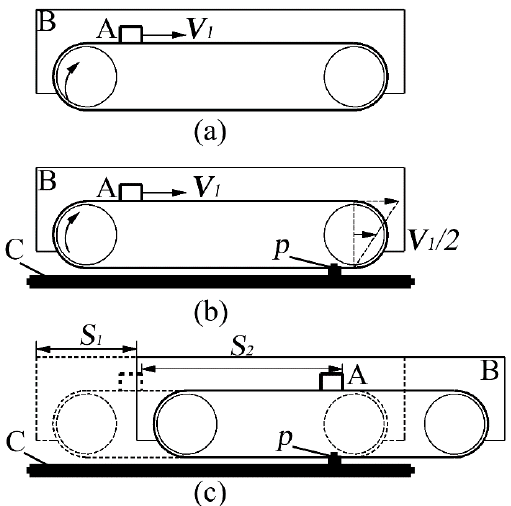
Figure 10. Rapier robot double-layer telescopic schematic. ( a ) Basic timing belt transmission structure; ( b ) double-layer telescopic speed schematic; ( c ) double-layer telescopic displacement schematic. The following parts are labeled: (V 1 ) belt speed, (A) object A, (B) plate B, (C) plate C, (p) fixed point of the belt, (S 1 ) moving distance of plate B, and (S 2 ) moving distance of object A.